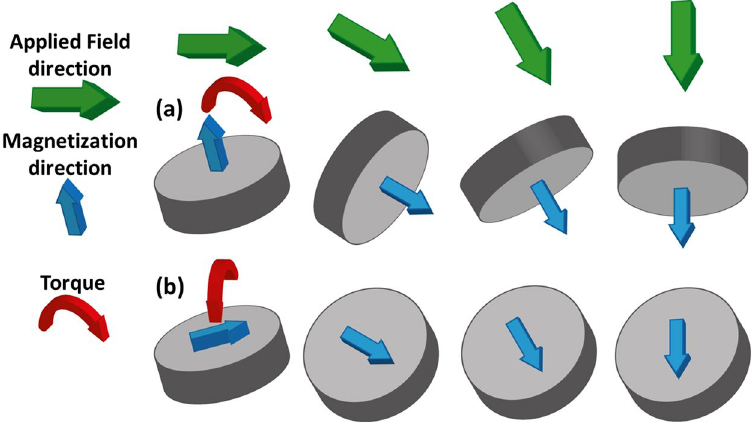
Figure 3. Schematic showing the magnetization direction and torques on ( a ) perpendicular particles (upper row) and ( b ) Py vortex particles (lower row) under an applied rotating